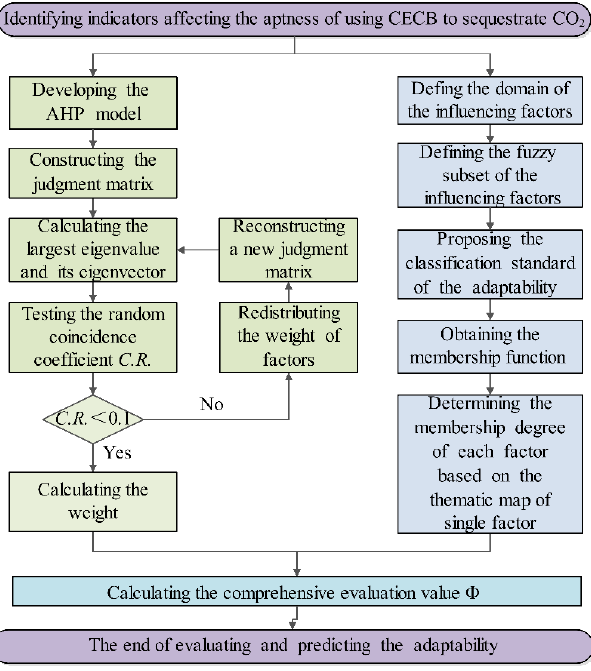
Figure 8. Process for evaluating and predicting the adaptability of using CECB to sequestrate CO 2